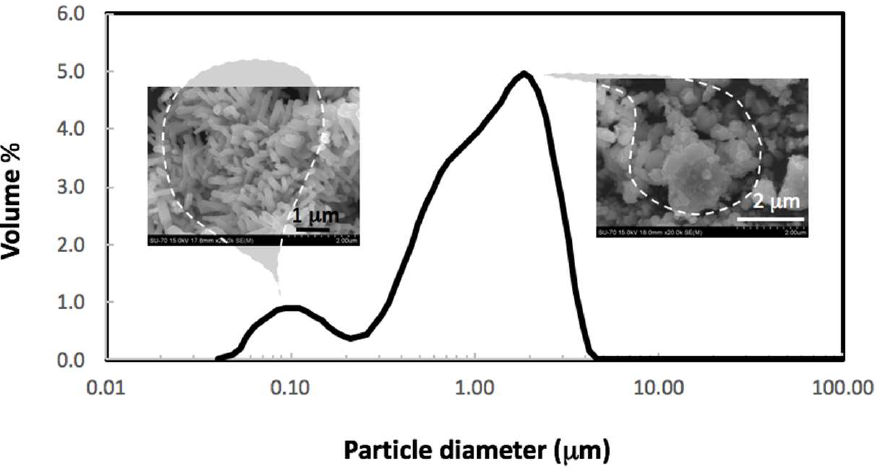
Figure 2. Particle size distribution and SEM images of the ZnO powder